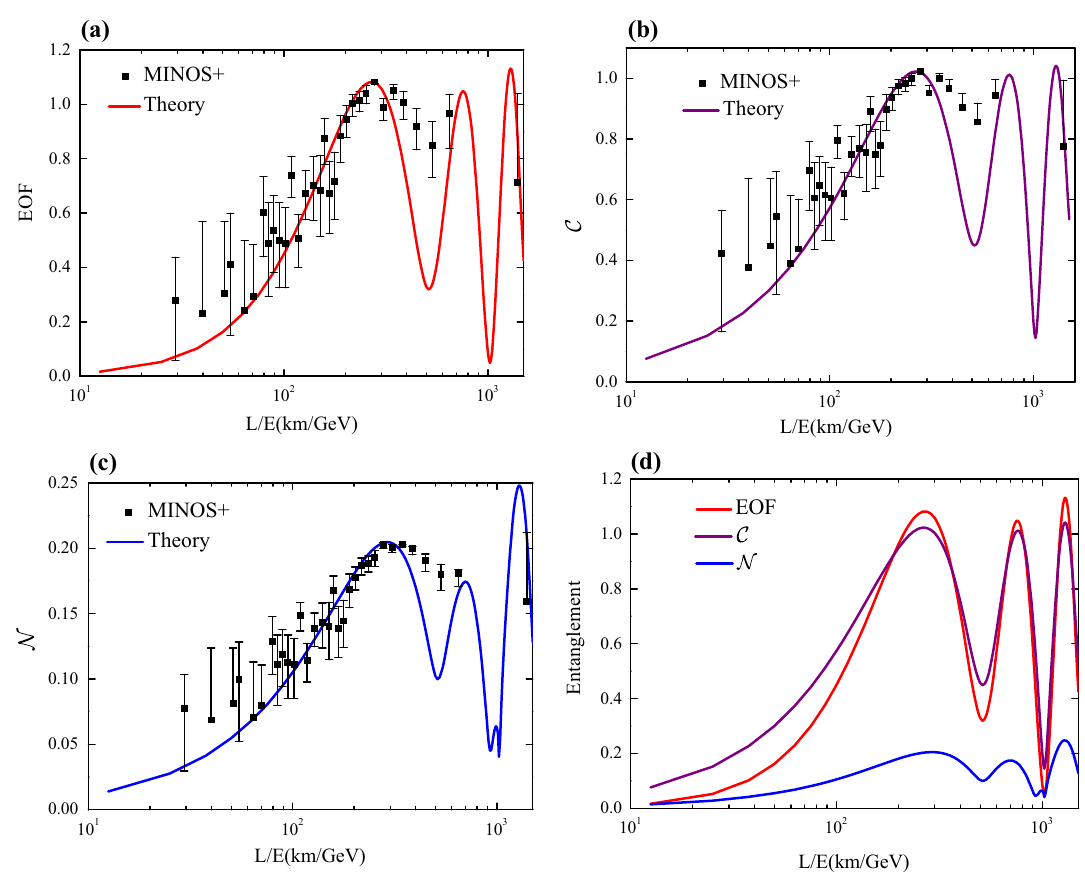
Fig. 5 Entanglement of formation (EOF), concurrence ( C ) and neg- ativity ( N ), as a function of L / E with an initial muon flavor state. a The red line denotes the theoretical EOF in Eq. (30); b The purple line denotes the theoretical concurrence in Eq. (32); c The blue line denotes our theoretical prediction for negativity in Eq. (31); d Comparison of